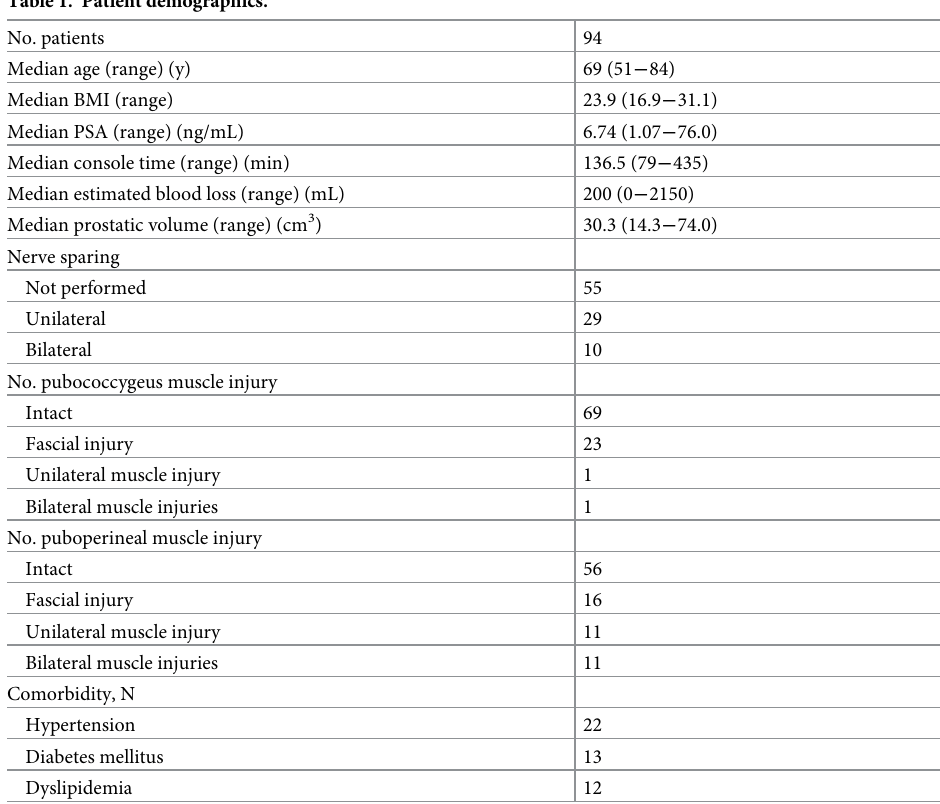
Table 1. Patient demographics. No. patients